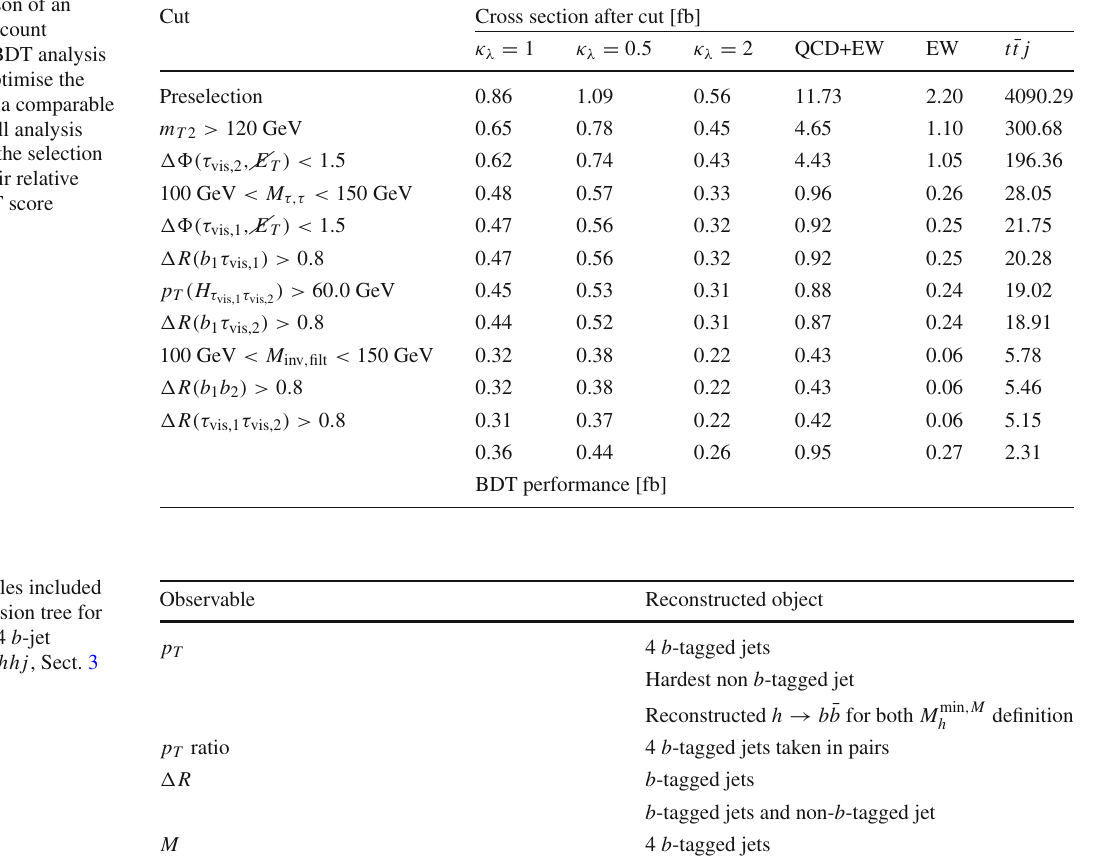
Table 6 Comparison of an optimised cut-and-count analysis with our BDT analysis of Sect. 2.4. We optimise the selection to obtain a comparable signal yield after all analysis cuts. The order of the selection criteria reflects their relative impact on the BDT score